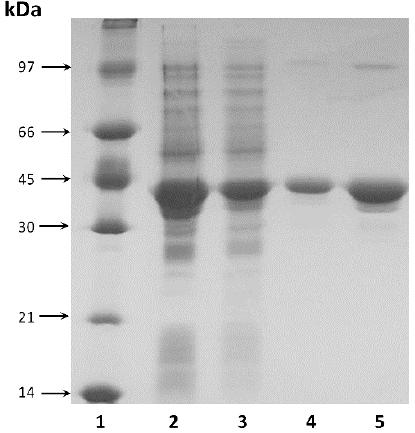
Figure 2. SDS-PAGE analysis: 1—protein molecular weight marker; 2, 3—TsA in cell free homogenate at concentrations 100 µg and 20 µg, respectively; 4, 5—purified TsA at concentrations 2 µg and 10 µg, respectively.